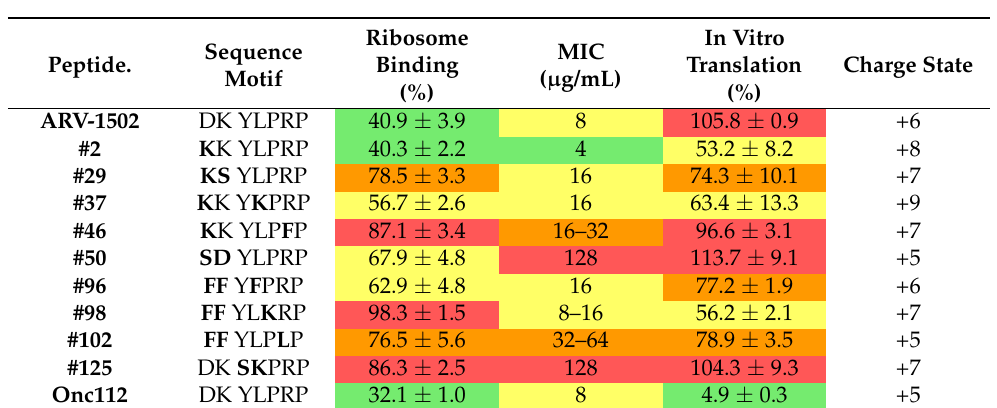
Table 3. Comparison of competitive ribosome binding against Cf-ARV-1502, MIC values obtained for E. coli BW25113 in 25% MHB2, and inhibition of the in vitro translation of GFP for ARV-1502 analogs with interesting properties. The strength of the different effects is indicated by the color code, i.e., red, orange, yellow, and green indicating no, moderate, strong and very strong effects,